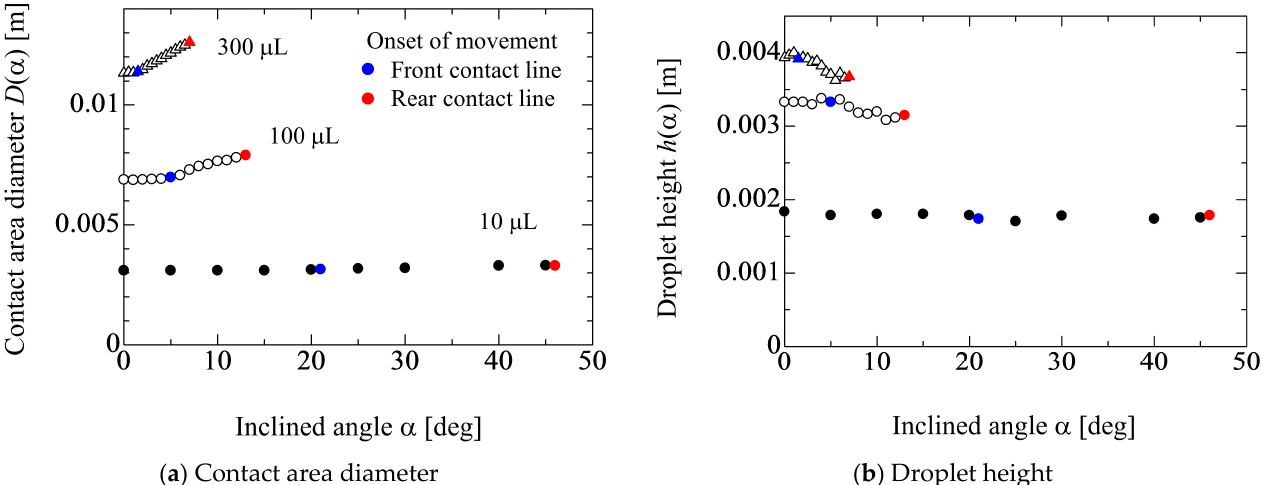
Figure 3. Relationship among contact area diameter D , height h of water droplet (0 wt%) and inclined angle α of solid substrate. The blue and red characters represent the front and rear contact lines movement, respectively.